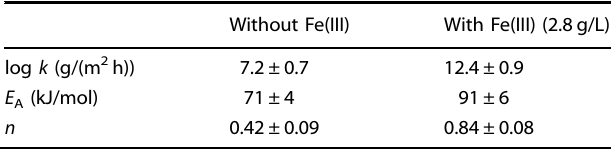
Table 2. Values of log k , E A and n fi tted from the R L (U) values obtained in the presence or in the absence of Fe(III) with various acid concentrations and